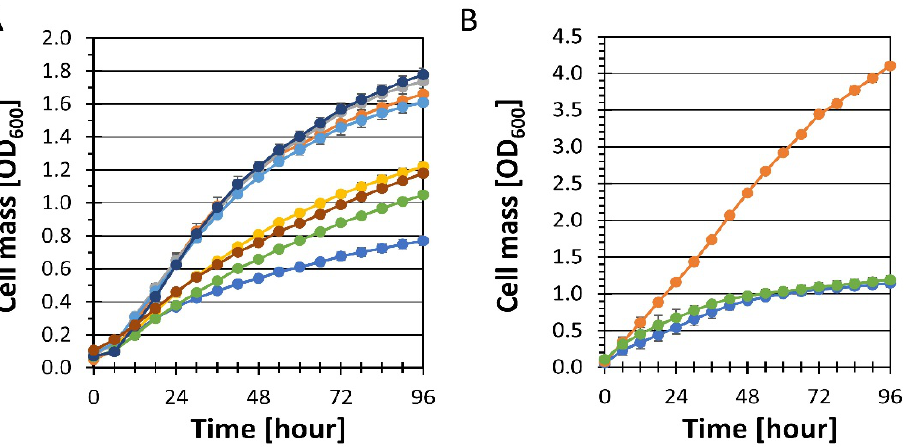
Figure 4. Expression of PBS2 and PHO13 in the adapted YRH1114 strain. ( A ) Plasmid-based expres- sion. Cells were grown on synthetic drop-out medium + 50 g/L xylose (SC5X). Amino acids were supplemented as required to maintain selection of empty vector control plasmids and PBS2 and PHO13 expression plasmids. Plasmid-based expression of PBS2 or PHO13 reduced growth on xy- lose. ( B ) Genome replacement of the pbs2 L363X allele. Strain YRH1934, with genomic pbs2 L363X allele replaced with wild-type PBS2 in YRH1114, was grown on xylose (YP5X medium) and compared to YRH1114 and YRH631. Plots are the average values from at least triplicate cultures. Error bars show standard deviations. Strain description: Panels ( A , B ) YRH631 (unadapted strain), YRH1114 (adapted strain); Panel ( A ) YRH1966 (YRH1114 + empty vector), YRH1968 (YRH1114 + PBS2 plasmid),